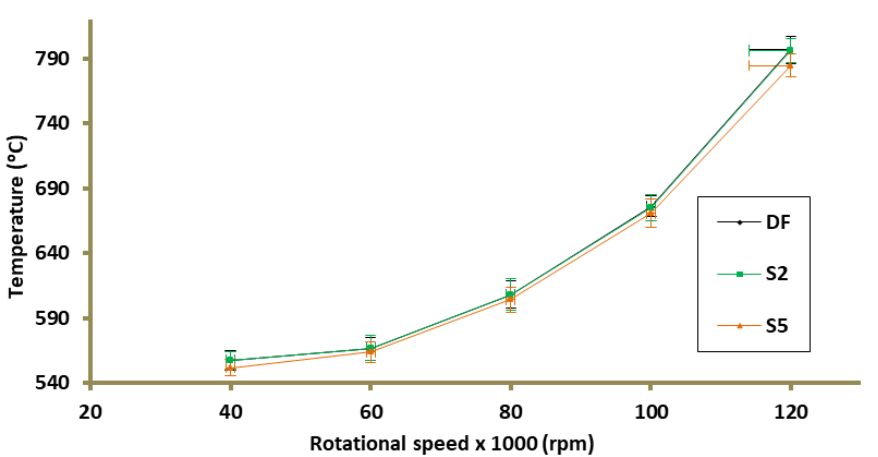
Figure 3. Temperature behind the combustion chamber as a function of engine rotational speed.